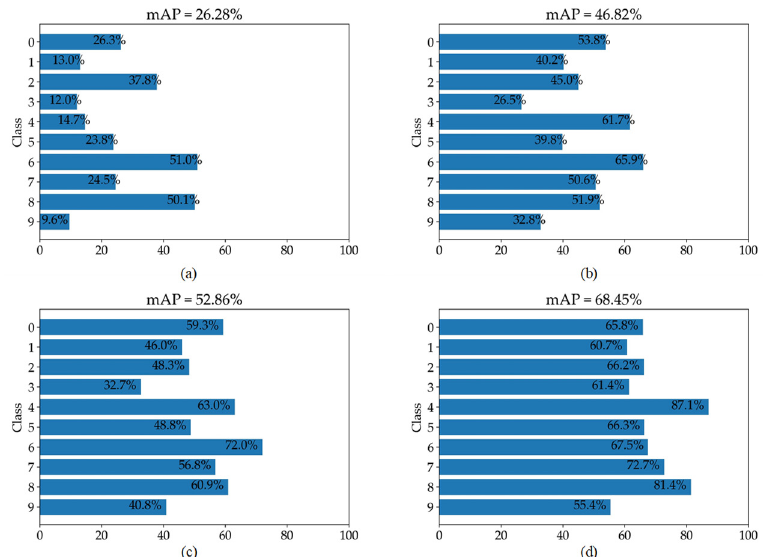
Figure 10. mAP comparison results for only numbers (0–9) on the UFPR dataset for scale factor ( × 4). ( a – d ) represent the mAP results on bicubic results, HIFA-LPR (Step 1) results, HIFA-LPR (Step 2) results, and HIFA-LPR (Step 3) results, respectively. Table 3. Comparison between the HIFA-LPR model and other existing approaches for scale factor (×3) on the Greek vehicle dataset.